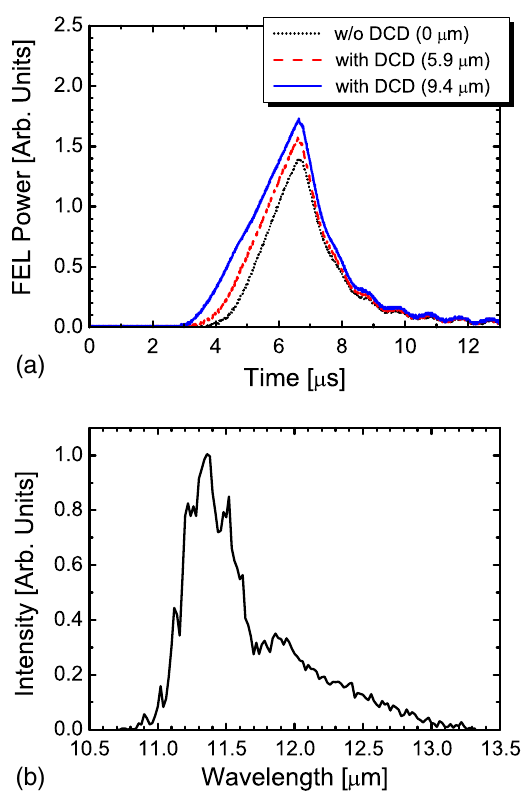
FIG. 9. (a) Typical FEL power evolution with different DCD parameters. (b) Typical FEL spectrum integrated over the macro- pulse with the DCD parameter of 9 . 4 μ m.